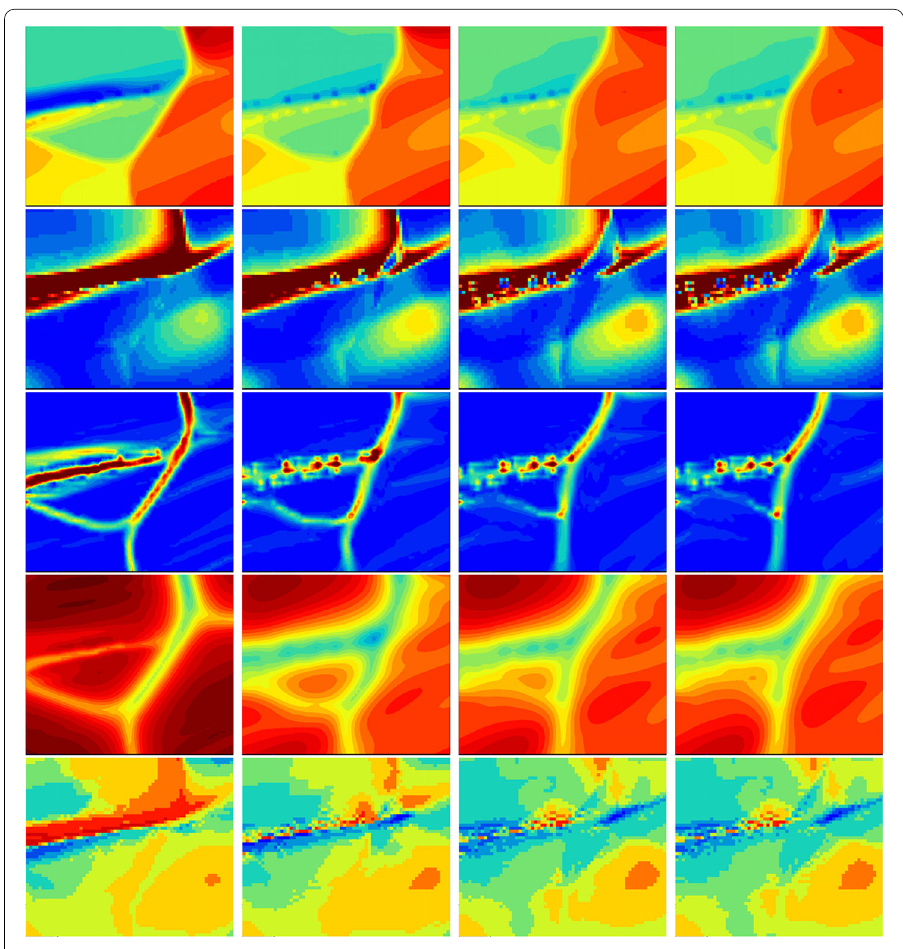
Fig. 12 A zoom on a new (sub-)grain boundary generated in the six grain microstructure due to kink band formation, c.f. Figs. 3 and 6 (the grain boundary appears in the lower left corner of the microstructure in those figures). From top to bottom the images show the orientation, the dislocation density ρ , the norm of the curvature |∇ θ | , the phase-field φ , and the resolved shear stress τ (ranging from − 160 to 230 MPa). The evolution is shown from left to right: just after deformation and then after 5min, 1h, and 2h of deformation. It appears that the reoriented bands (blue above and yellow below) are slightly fragmented, with scattered darker spots. As the microstructure evolves, the reoriented bands start to vanish except for these spots, which appear to remain. In the stored energy, blue regions appear at the same positions, indicating that static recovery has taken place